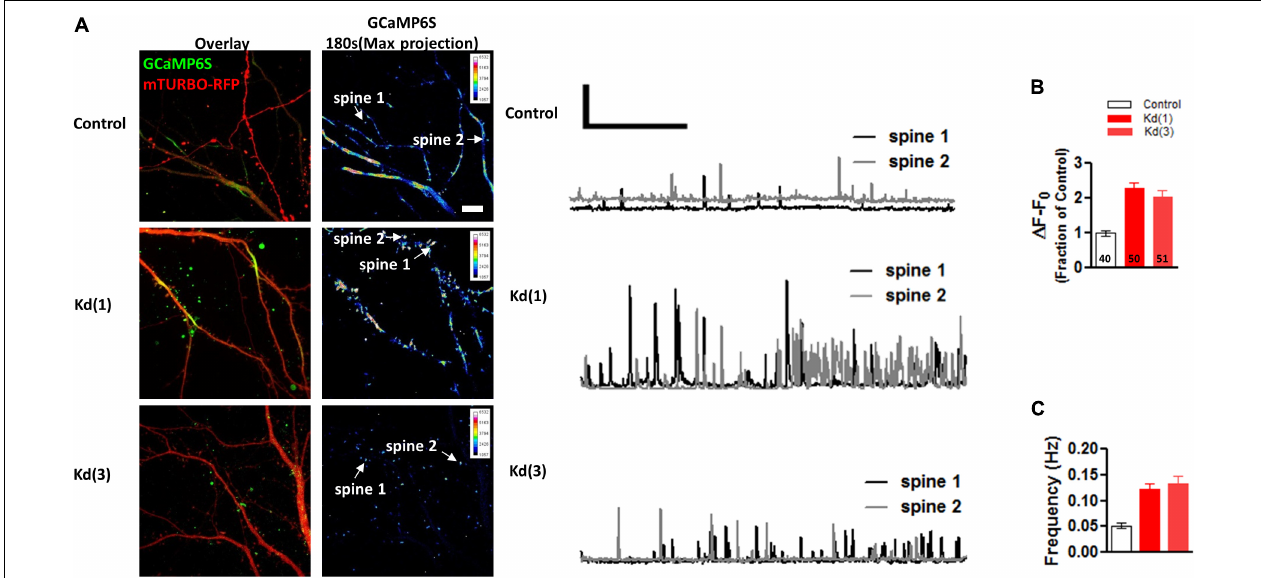
FIGURE 7 | Pin1 downregulation increases the NMDAR-mediated GCaMP6S Ca 2 + signals in single spines. (A) Spinning disk confocal images showing maximum projections of the GCaMP6S, Turbo-mRFP (shRNA channel), and the overlay image. Control and the two knockdown conditions are shown. 3 min of imaging time compressed into a maximum projection pseudocolor images of the GCaMP6S channel. Intensity scale shown on upper right quadrant. (middle) Two 180 s long traces showing the transient increases in fluorescence plotted as (cid:49) F/F for the spines indicated in (A) . Scale bar 1X (cid:49) F/F and 50 ms. (B) Quantification of (cid:49) F/F signal intensity for control or knockdown expressing cells. Control 1.00 ± 0.09, n = 40 spines, 9 cells; Kd (1) 2.35 ± 0.17, n = 50, 14 cells; Kd (3) 2.19 ± 0.28, n = 51, 12 cells. One-way ANOVA with Bonferroni’s multiple comparison test, F (2,64) = 17.96, p < 0.0001. Scale bar: 10 µ m. (C) Quantification of single spine event frequency for control or knockdown expressing cells. Control 0.05 ± 0.005, n = 40 spines, 9 cells; Kd (1) 0.13 ± 0.02, n = 50, 14 cells; Kd (3) 0.05 ± 0.01, n = 51, 12 cells. One-way ANOVA with Bonferroni’s multiple comparison test, F (2,64) = 8.81, p <